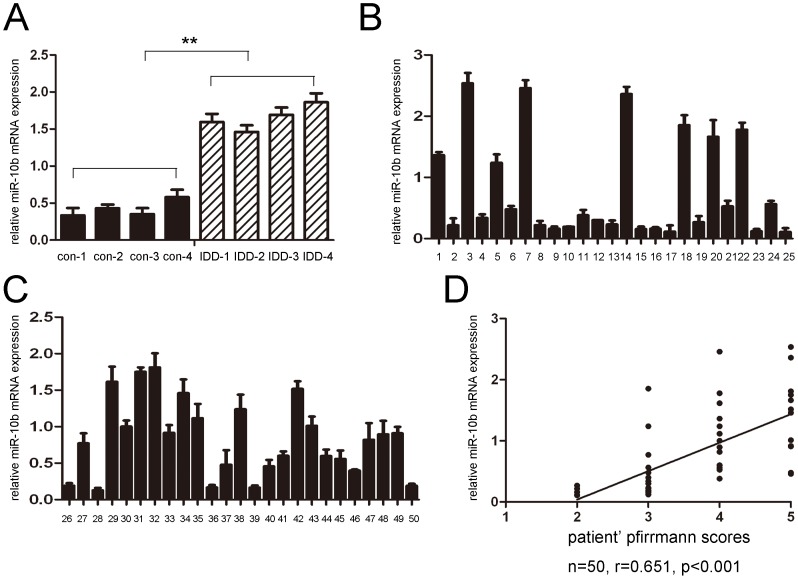
The expression of miR-10b in human nucleus pulposus tissues.(A) The expression of miR-10b in 4 degenerative nucleus pulposus tissues and 4 idiopathic scoliosis nucleus pulposus tissues. These degenerative NP tissues exhibited extraordinatily high expression of miR-10b compared to the control. (B) and (C) TaqMan RT-PCR analysis of miR-10b in the human nucleus pulposus tissue of 37 patients. (D) The correlation between the expression of miR-10b and disc degeneration grade of the patients. Error bars represent SD. **indicates p<0.01.